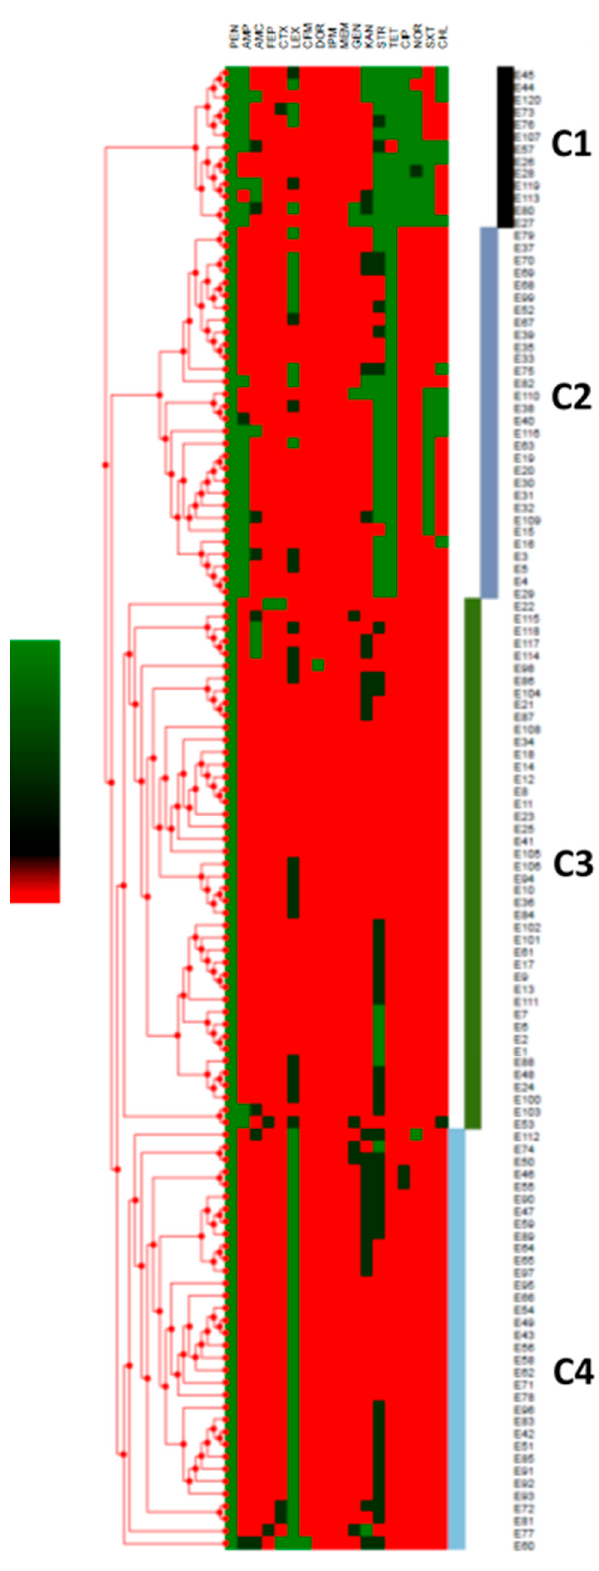
Figure 2. Hierarchical clustering of the antimicrobial resistance (AMR) profiles of each E. coli ( n = 120) isolated from minced beef meat in Lebanon. The strains were labelled E1 to E120. The green color in the scale and the heat map represents resistance, while black and red indicate intermediate resistance and susceptibility, respectively. The letter C indicates clusters.